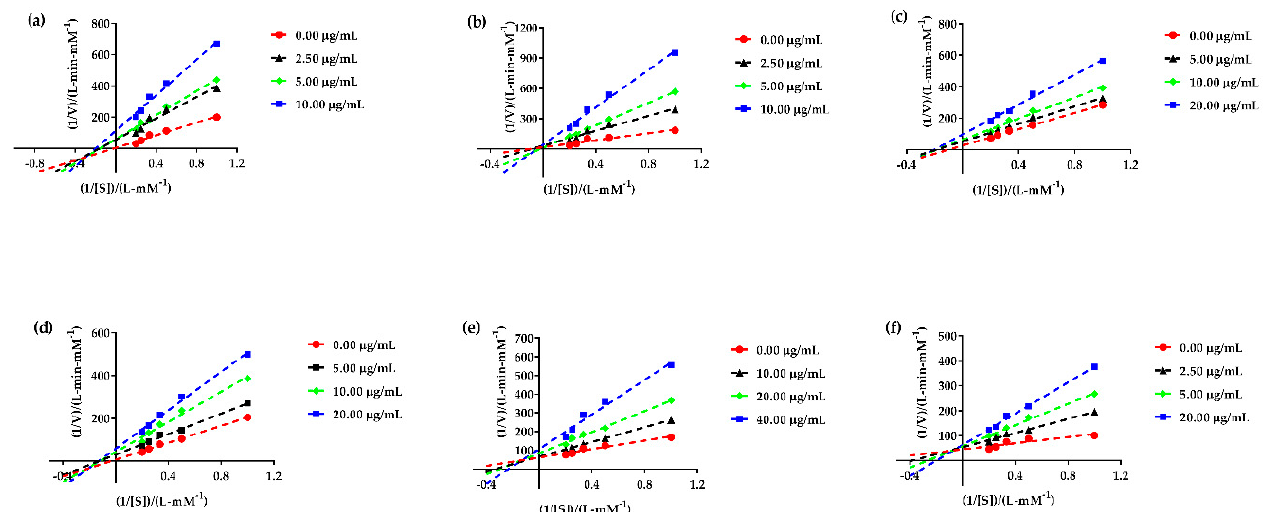
Figure 8. The Lineweaver–Burk plot of T. grandis methanolic extract, fractions and compounds 5 and 7. ( a ) 1/[S]–1/V fitting curve of ME. ( b ) 1/[S]–1/V fitting curve of PEE. ( c ) 1/[S]–1/V fitting curve of EAE. ( d ) 1/[S]–1/V fitting curve of NBE. ( e ) 1/[S]–1/V fitting curve of compound 5 . ( f ) 1/[S]–1/V fitting curve of compound 7 . All values are mean ± SD from three independent experiments. ME: